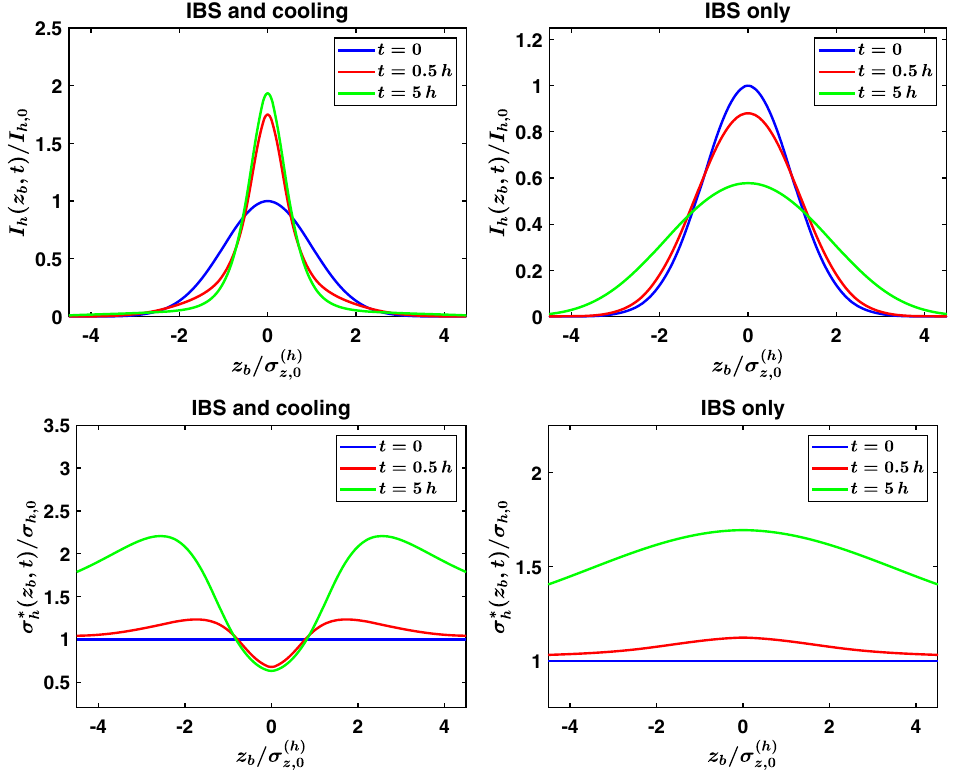
FIG. 7. Upper panel: hadron current profiles at selected times during the cooling process. Lower panel: hadron local energy spread profiles at the same times. As in Fig. 6, we include data with and without